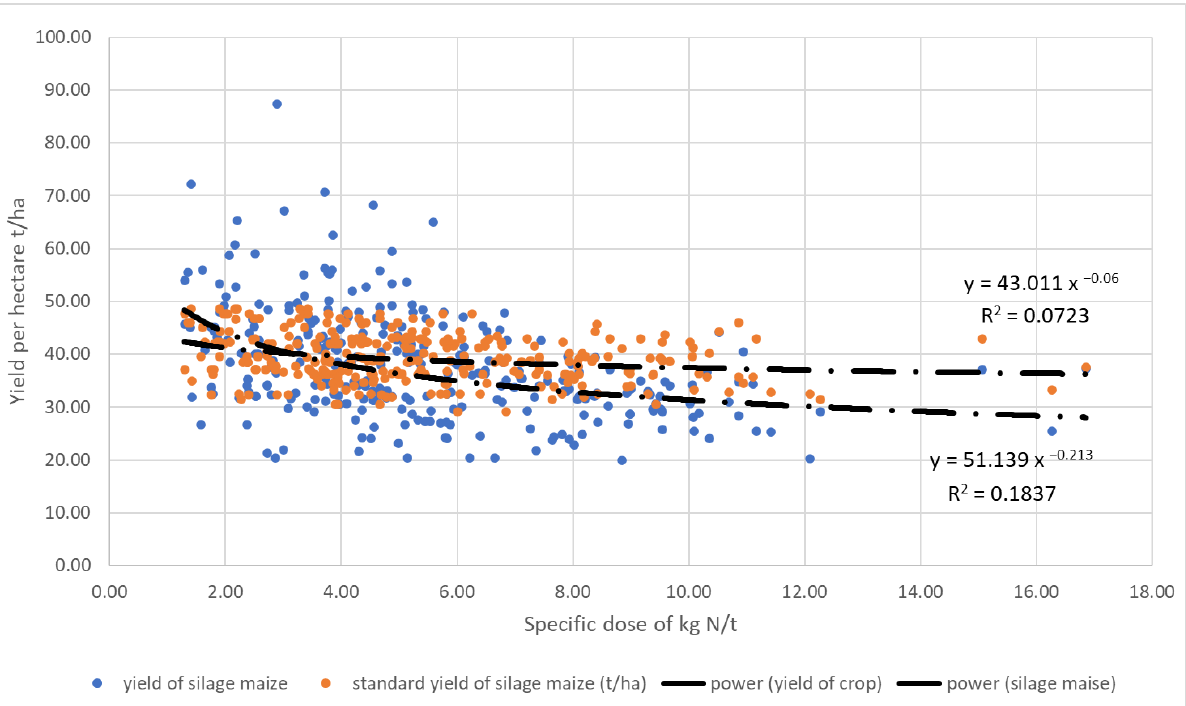
Figure 2. Silage maize yield and specific nitrogen consumption per tonne of production depending on soil fertility. The increase in specific fuel consumption per tonne of production occurs from approx- imately the standard yield of 40